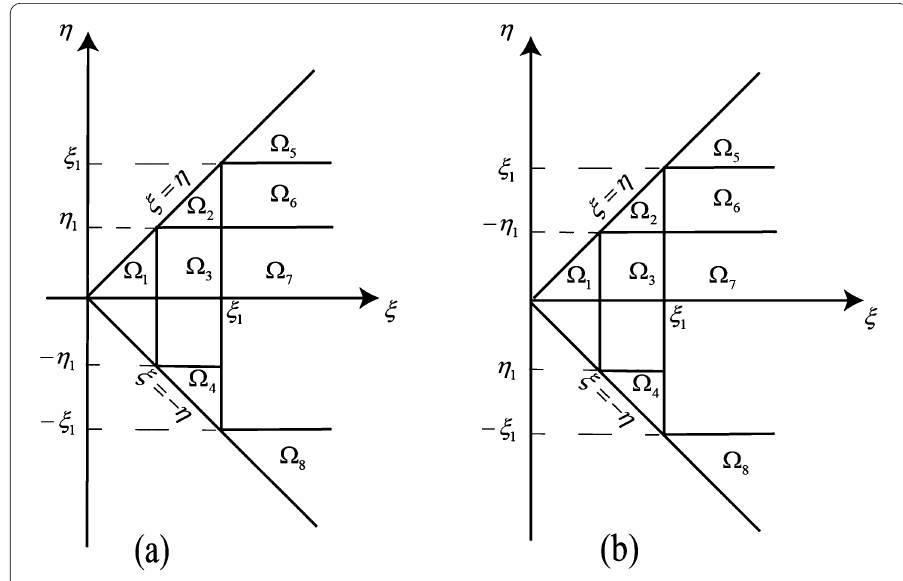
Figure 6 ( a )—splitting the domain (cid:10) , when η 1 > 0; ( b )—splitting the domain (cid:10) , when η 1 <